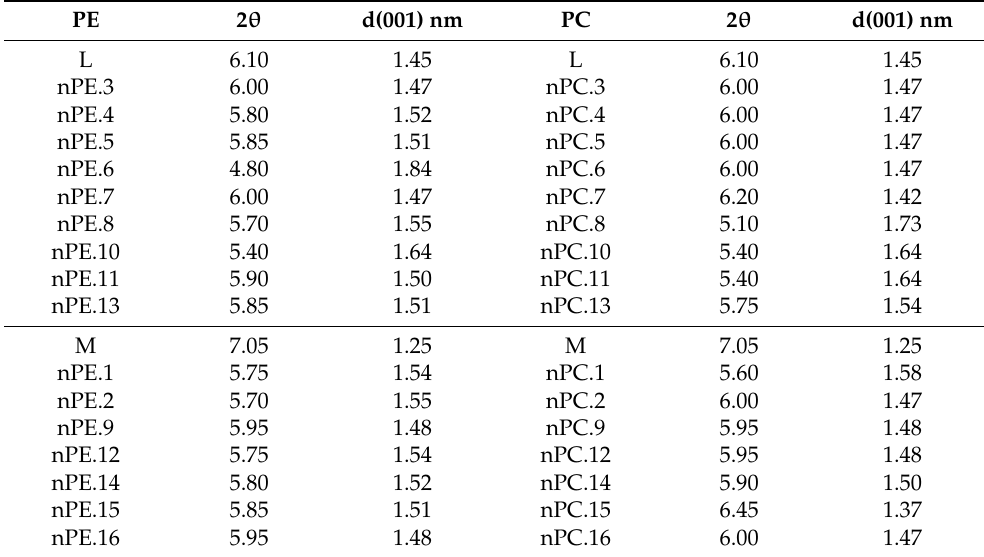
Table 6. Interlaminar space d(001)nm from the M and L original clays, and hybrid pigments with PE and PC under different synthesis conditions [1–16].